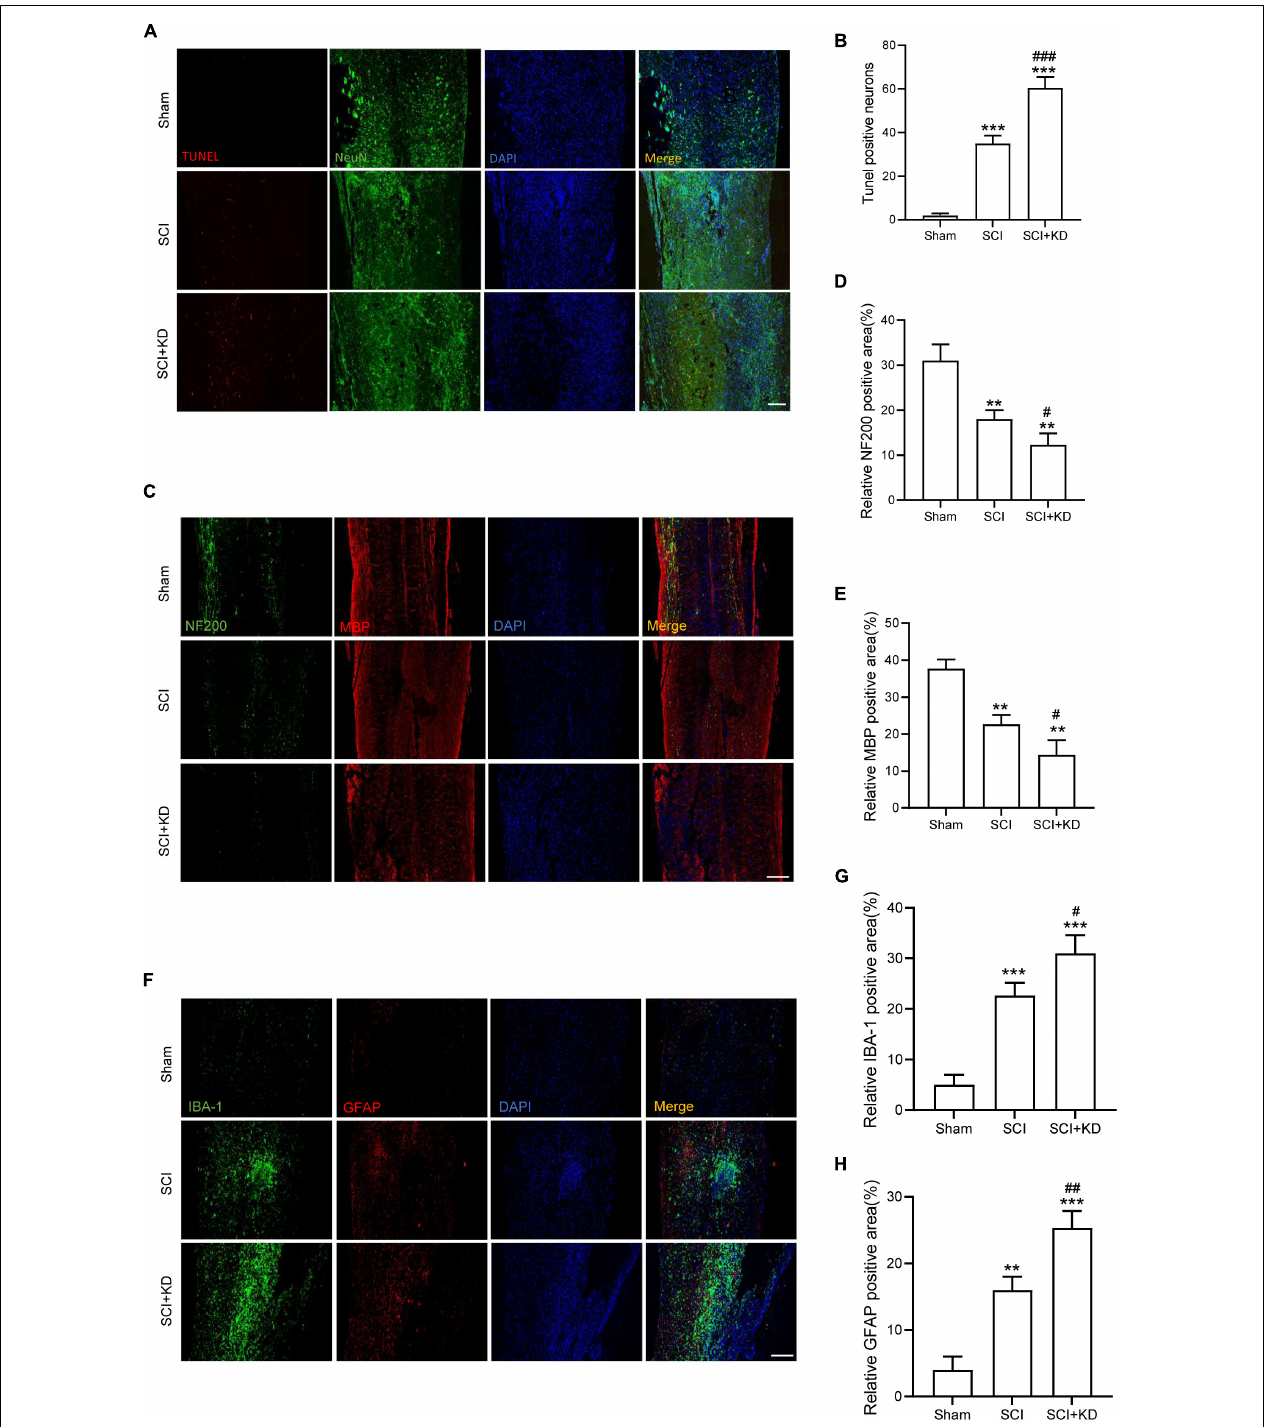
FIGURE 5 | Inhibition of GDF15 aggravated neurological damage and neuroinflammation. (A) Neuronal death determined by TUNEL assay at 7 dpi in Sham, SCI, and SCI + KD mice (Scale bar = 200 µ m). (B) Quantitative analysis of TUNEL-positive neurons. (C) Representative immunofluorescence labeling of neurofilaments for NF200 (green) and myelin sheath for MBP (red) and obtained from longitudinal sections centered around the injured core 1.5 mm at 28 dpi (Scale bar = 300 µ m). (D) Quantitative analysis of NF200 positive area at 28 dpi ( n = 6). (E) Quantitative analysis of MBP positive area at 28 dpi ( n = 6). (F) Double immunofluorescence labeling of microglia for IBA-1 (green) and astrocytes for GFAP (red) obtained from longitudinal sections centered around the injured core 3 mm at 7 dpi (Scale bar = 300 µ m). (G) Quantitative analysis of IBA-1 positive area at 7 dpi. (H) Quantitative analysis of GFAP positive area at 7 dpi. The error bars represent the SD. ** p < 0.01, *** p < 0.001, vs. Sham group; # p < 0.05, ## p < 0.01, ### p < 0.001, vs. SCI group by t-test, one-way ANOVA followed by Tukey’s post hoc